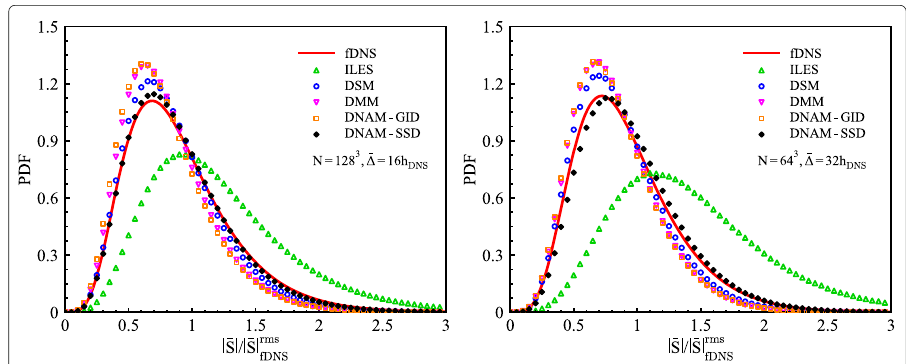
Fig. 10 PDFs of the normalized characteristic strain rate in aposteriori